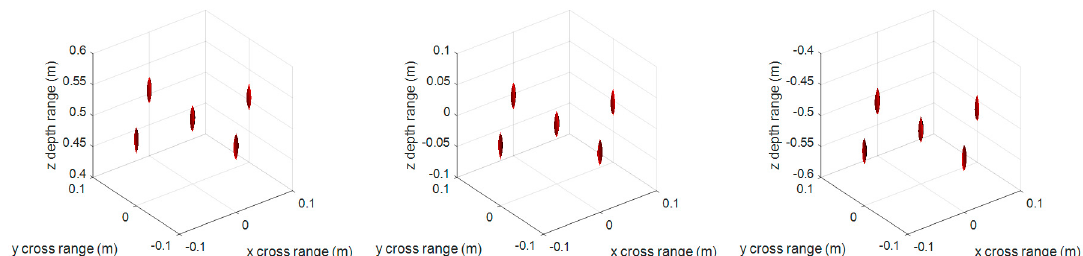
Figure 3. 3-D imaging results of the conventional range migration algorithm (RMA) with compensation distance 0 ( left ), 0.51 m ( middle ), and 1.02 m ( right ).